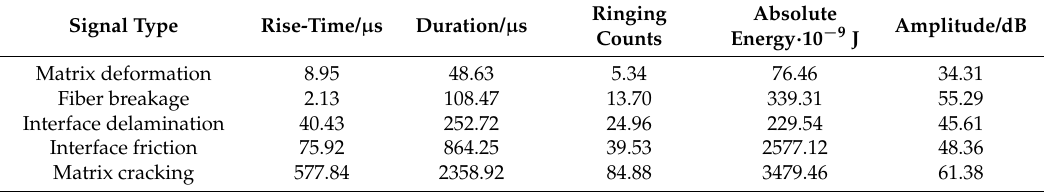
Figure 4. Five AE characteristic waveforms corresponding to the damage and fracture mode. ( a ) Type I (Matrix deformation); ( b ) Type II (Fiber breakage); ( c ) Type III (Interface delamination); ( d ) Type IV (Interface friction); and ( e ) Type V (Matrix cracking). Table 1. Characteristics of AE signals corresponding to several damage modes.